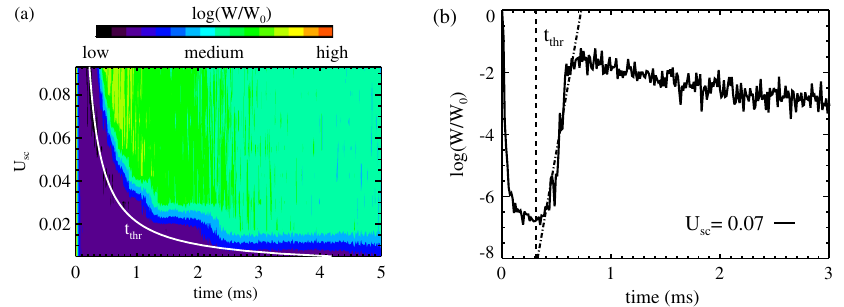
FIG. 7. Simulation scan of the total electric field energy W divided by the initial field energy W 0 for different microbunch intensities versus time. The white line in (a) indicates the time needed to reach the critical number of filaments given through Eq. (28). The initial ¼ 0 : 42 . Part (b) shows the total electric field energy for bunching factor of the microbunches in the simulation is chosen as B f U sc ¼ 0 : 07 . The time t thr ¼ 0 : 31 ms for this case is indicated by the dashed, vertical line. The dotted dashed curve represents the exponential increase of the multistream instability.